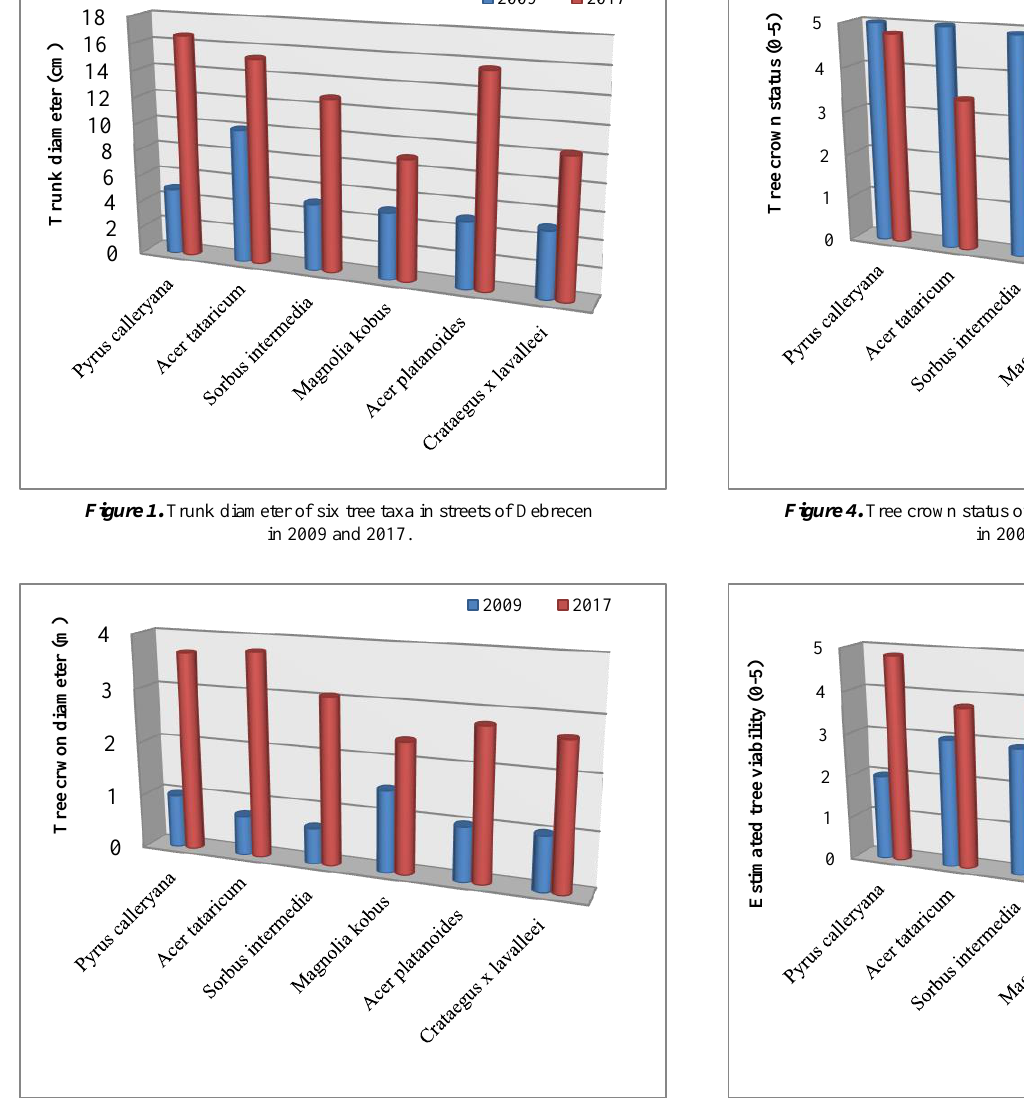
Figure 5. Estimated tree viability of six tree taxa in streets of Debrecen in 2009 and 2017. Trunk status of the six tree taxa were between 4.95 and